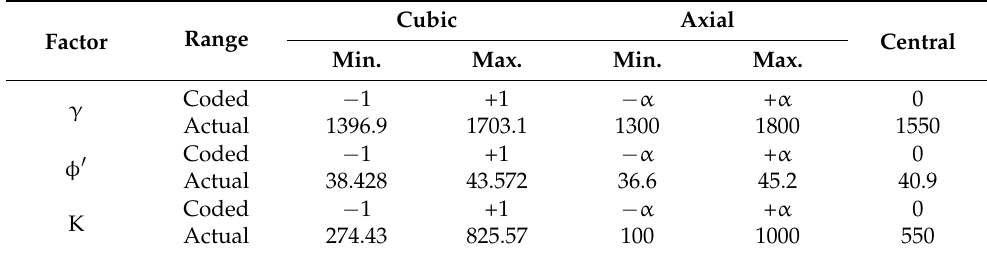
Table 1. Ranges of the sample values of the input variables.